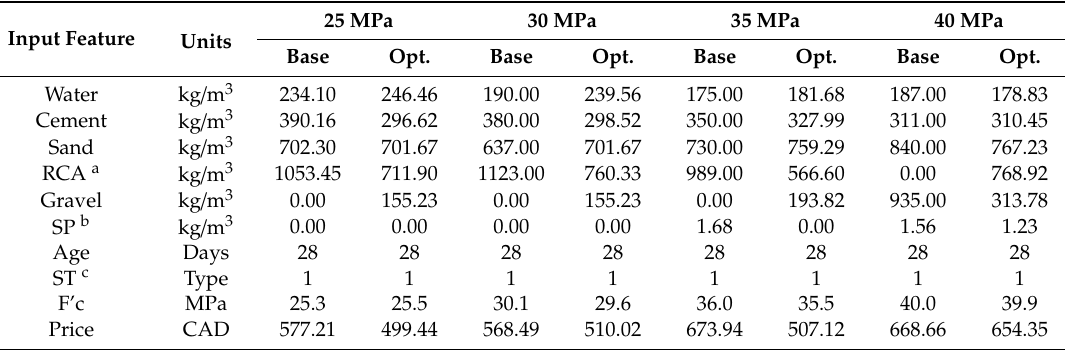
Table 10. Comparison of optimized mixture with base